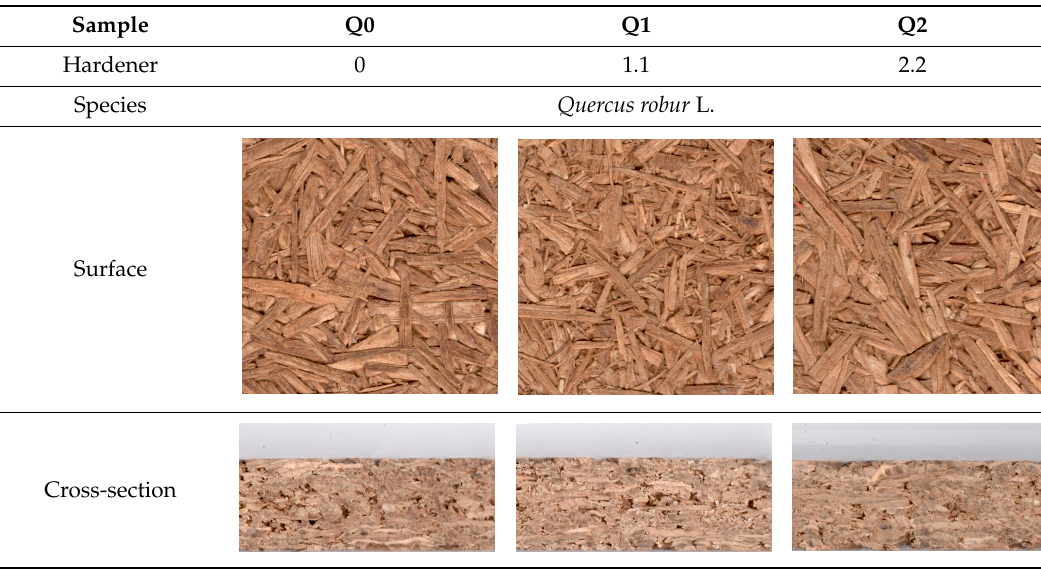
Table 4. Sample appearance of the boards made of oak.